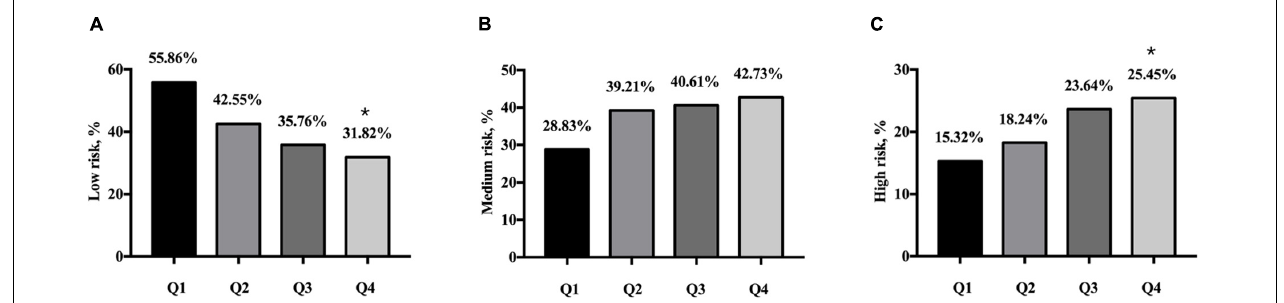
FIGURE 2 | Ten-year ASCVD risk categories by China-PAR according to quartiles of serum uric acid. (A) Percentage of low risk in quartiles of SUA. (B) Percentage of medium risk in quartiles of SUA. (C) Percentage of high risk in quartiles of SUA. Q1: SUA ≤ 4.78 mg/dL, n = 333; Q2: SUA 4.78–5.83 mg/dL, n = 329; Q3: SUA 5.83–6.86 mg/dL, n = 330; Q4: SUA ≥ 6.86 mg/dL, n = 330. ASCVD, atherosclerotic cardiovascular disease; SUA, serum uric acid. * p < 0.05 (the Q4 group vs. the Q1 group).